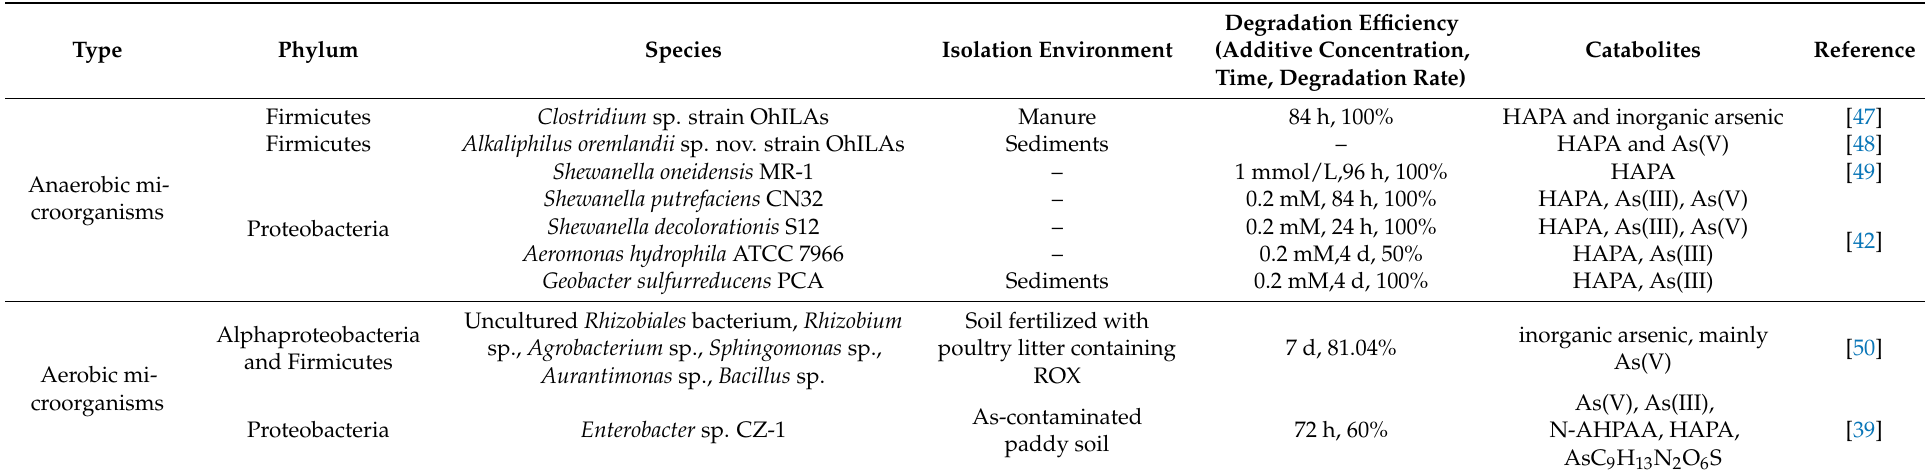
Table 1. Microorganisms that degrade